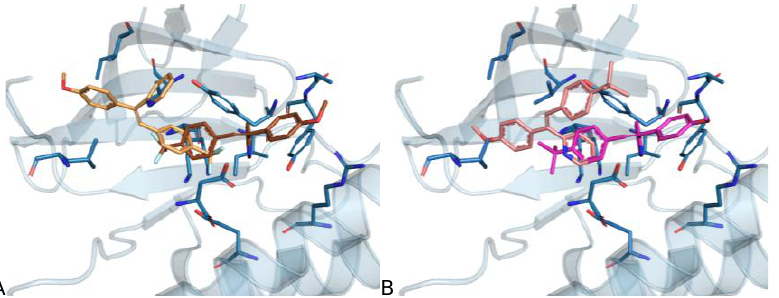
Figure 9. ( A ) Difference in the predicted binding mode of compound 12a in the ERK-1 (in orange) and in the ERK-2 (in brown) binding sites. ( B ) Difference in the predicted binding mode of compound 10a in the ERK-1 (in pink) and in the ERK-2 (in magenta) binding site.